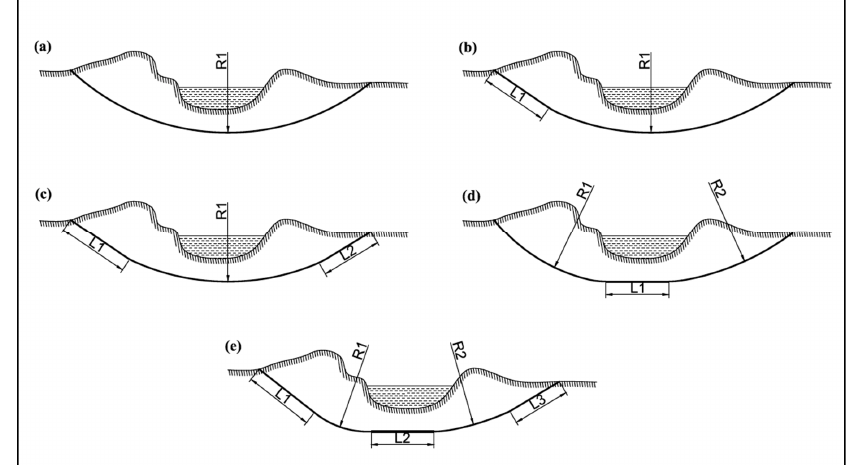
Figure 1. Horizontal directional drilling trajectories as a combination of straight and curvilinear sections: ( a ) one curvilinear section; ( b ) straight section and one curvilinear section; ( c ) two straight sections and one curvilinear section; ( d ) straight section and two curvilinear sections; ( e ) three straight sections and two curvilinear sections .